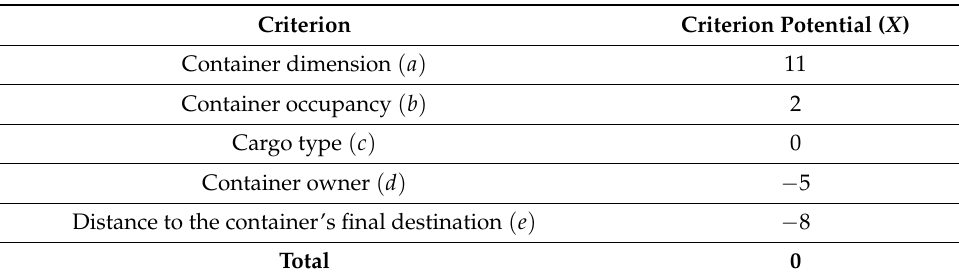
Table 3. Potential of inconsistent